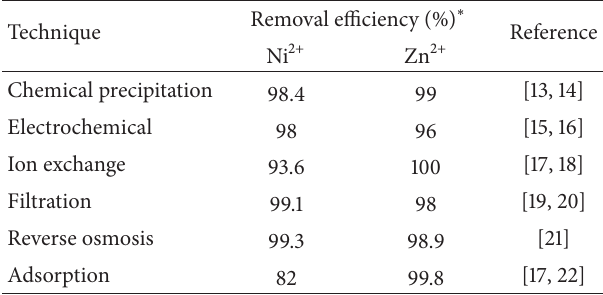
Table 1: Efficiencies of the current methods and sorption technique in removal of Ni 2+ and Zn 2+